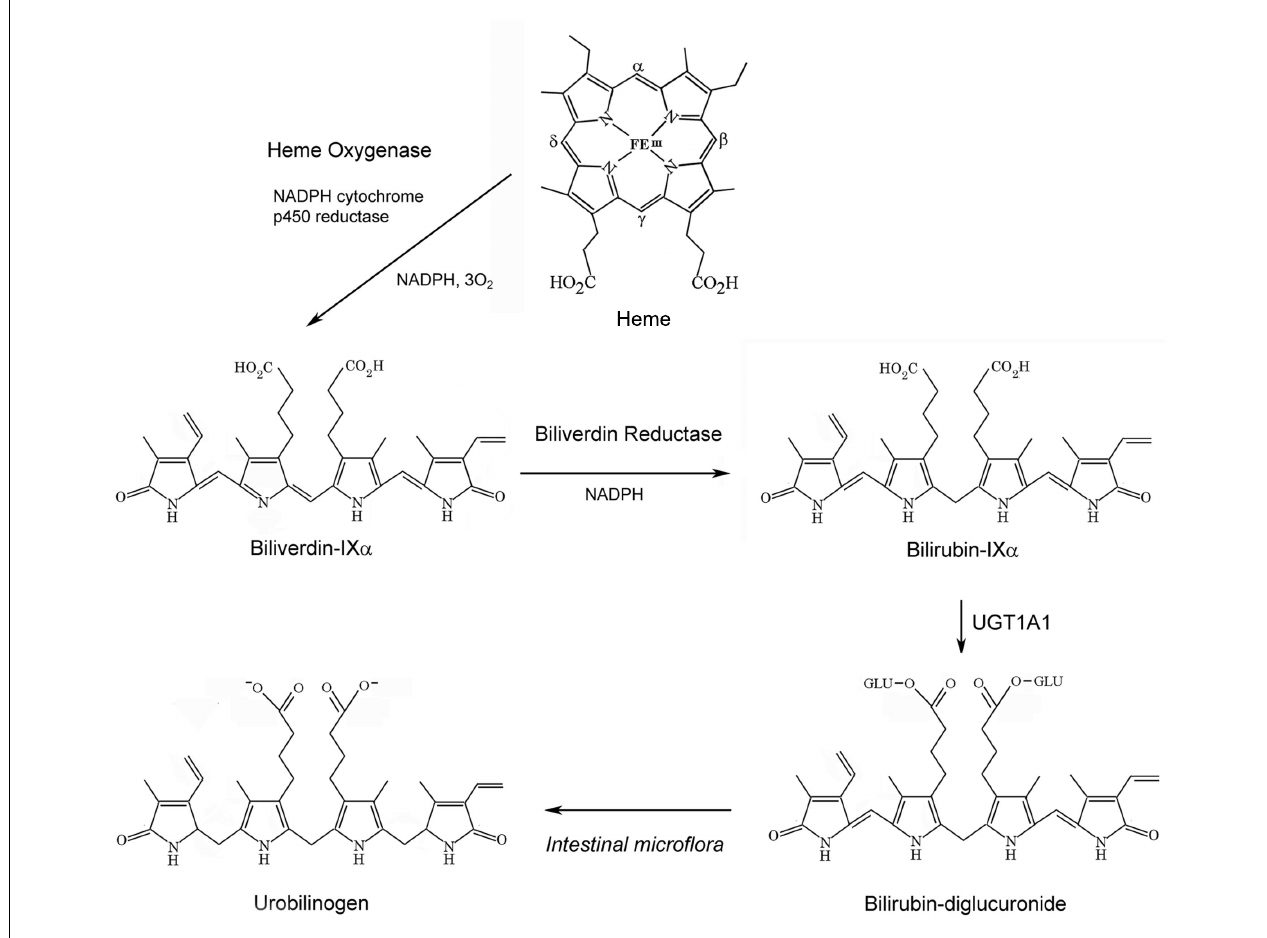
biliverdin reductase (BVR). BR is conjugated with glucuronic acid at its propionyl side chains by hepatic UDP-glucuronyltransferase-1A1 (UGT1A1), to form BR mono- and di-glucuronides. BR can be further metabolized to urobilinogen by intestinal